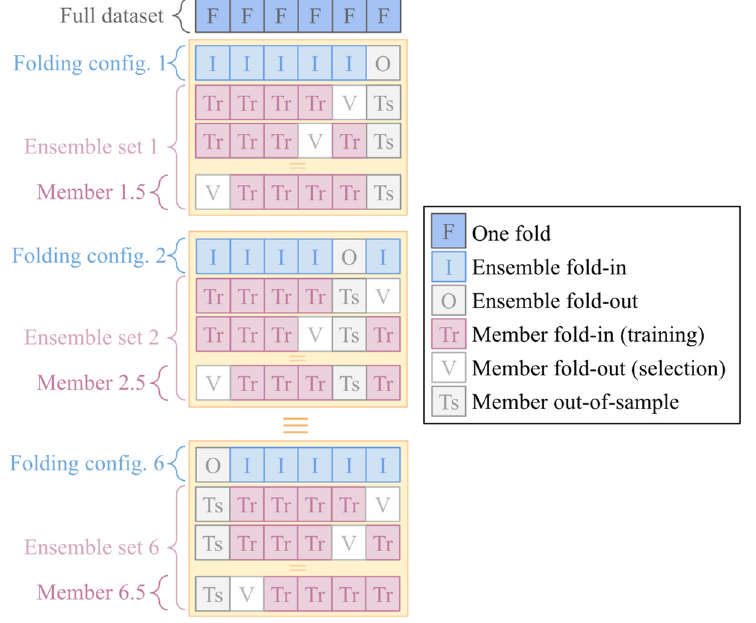
Figure 4. Data organization scheme of the cross-folding configurations and ensemble members training setup.